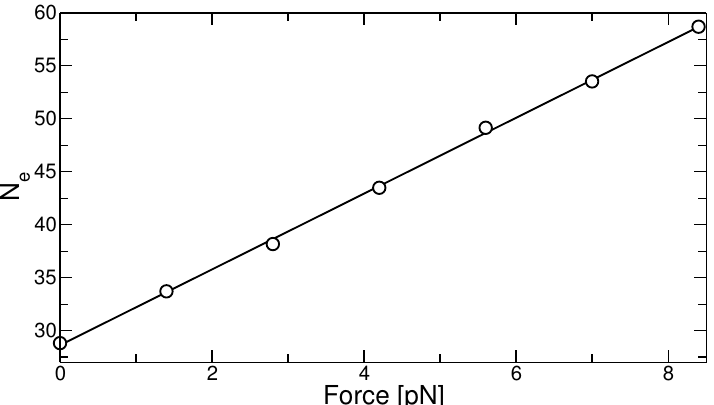
Figure 3. Entanglement length in units of monomers obtained from PPA analysis as a function of applied force.